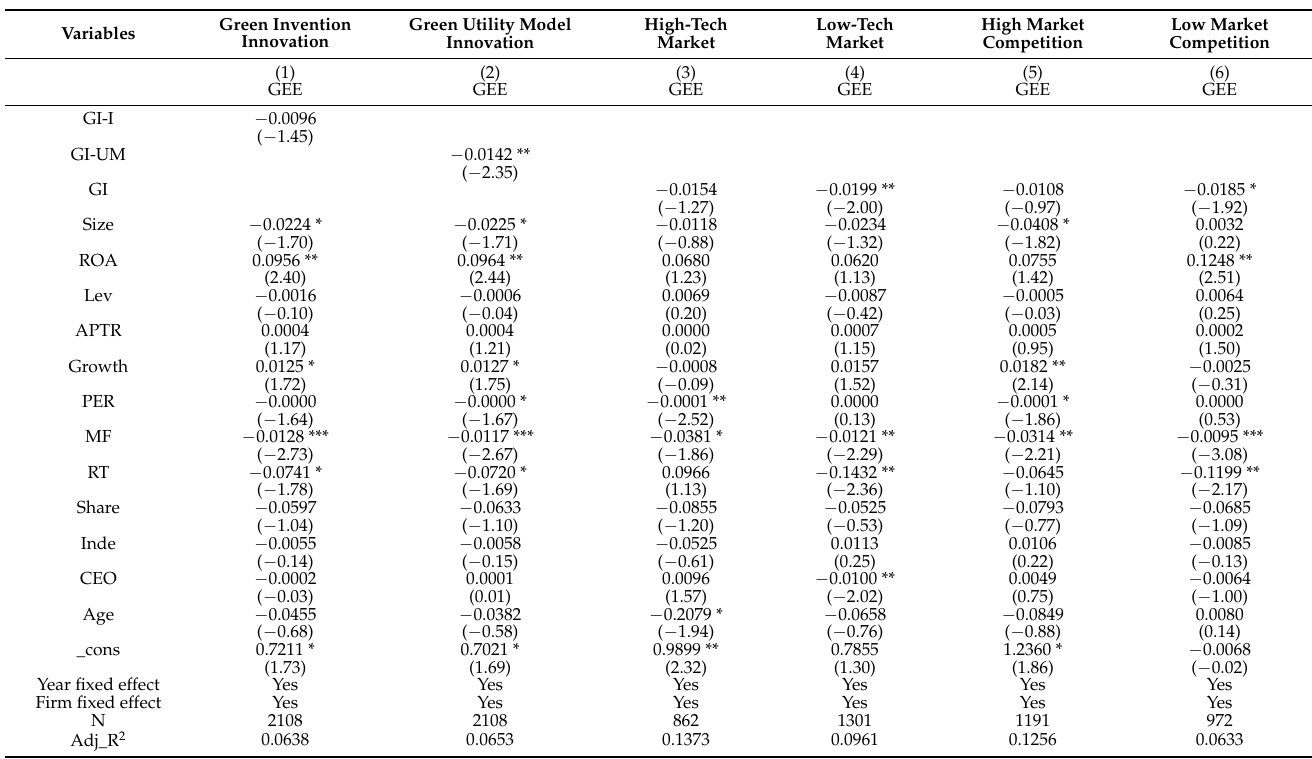
Table A12. Influence of innovation form, freedom of technological selection, and market competition intensity (Full version of Table 5).